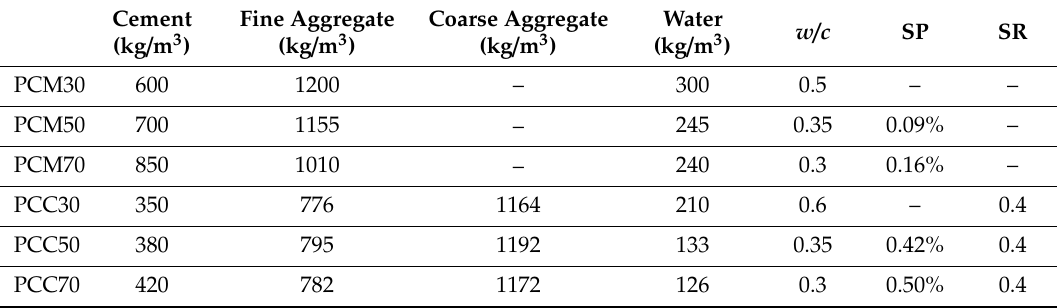
Table 2. Mix proportions of the Portland cement mortar (PCM) and the Portland cement concrete (PCC) [12].